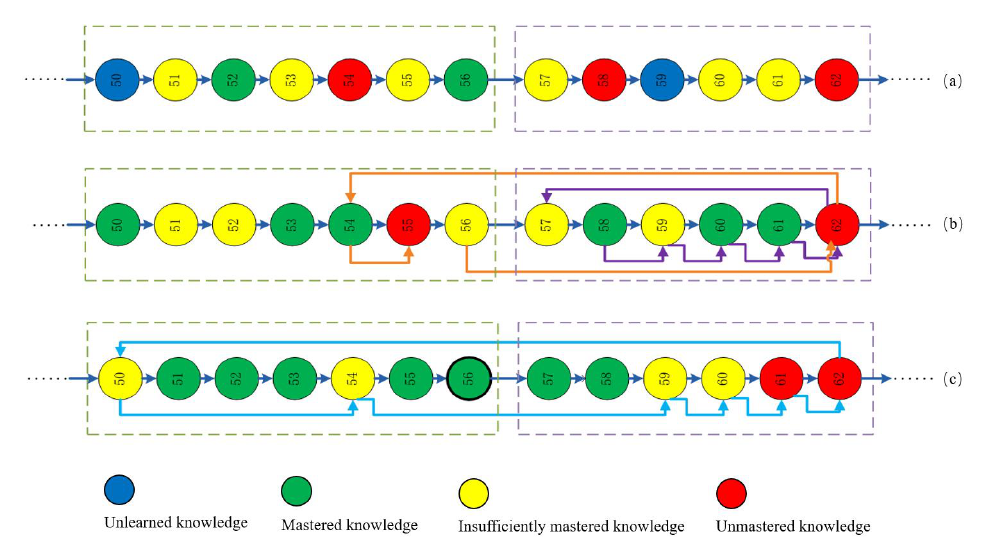
Figure 3. ( a – c ) is three typical learning paths of MOOC learning. ( a ) is a typical linear learning path of student in MOOCCubex; ( b ) is typical circular learning path of student in MOOCCubex; ( c ) is a learning path automatically generated by the